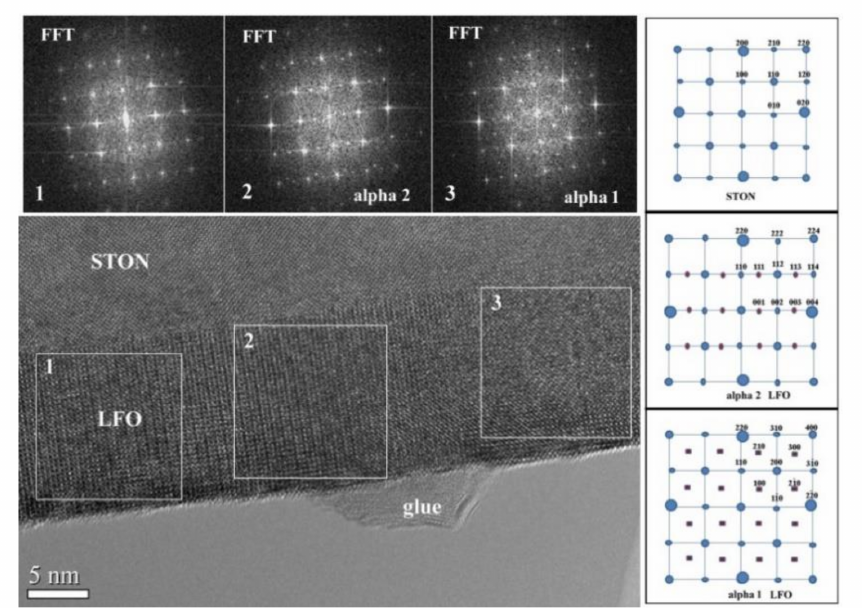
Figure 11. HRTEM of 15 nm LFO/STON film showing the two different orientations of the [001] LFO direction respective to the (100) STON substrate plane: alpha 1, the [001] LFO is parallel to the image normal (microscope axis), and alpha 2, the [001] LFO is in the image